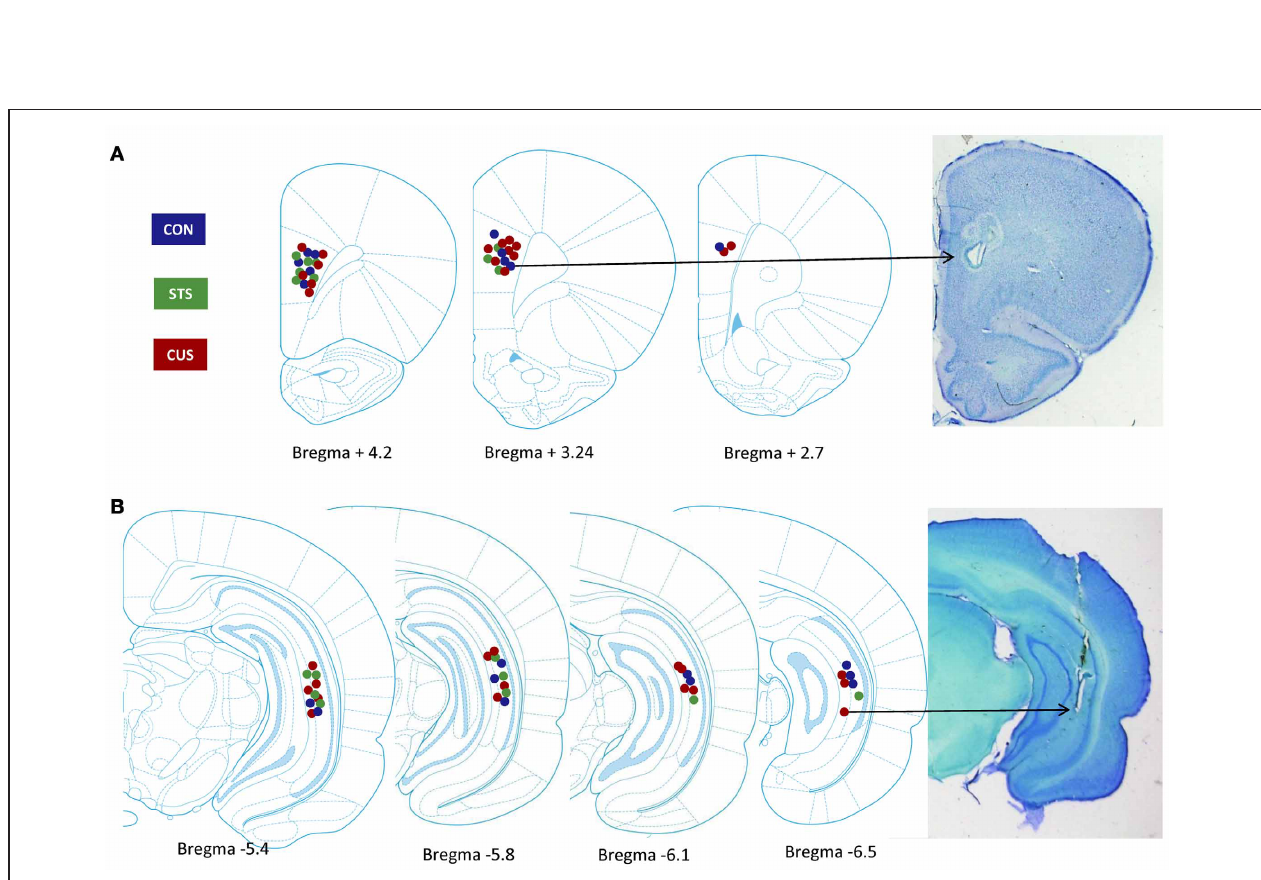
FIGURE A4 | Identification of electrode recording sites. Left panel, recording site location in control (CON, blue), short term stress (STS, green) and chronic unpredictable stress (CUS, red) rats, within the medial prefrontal